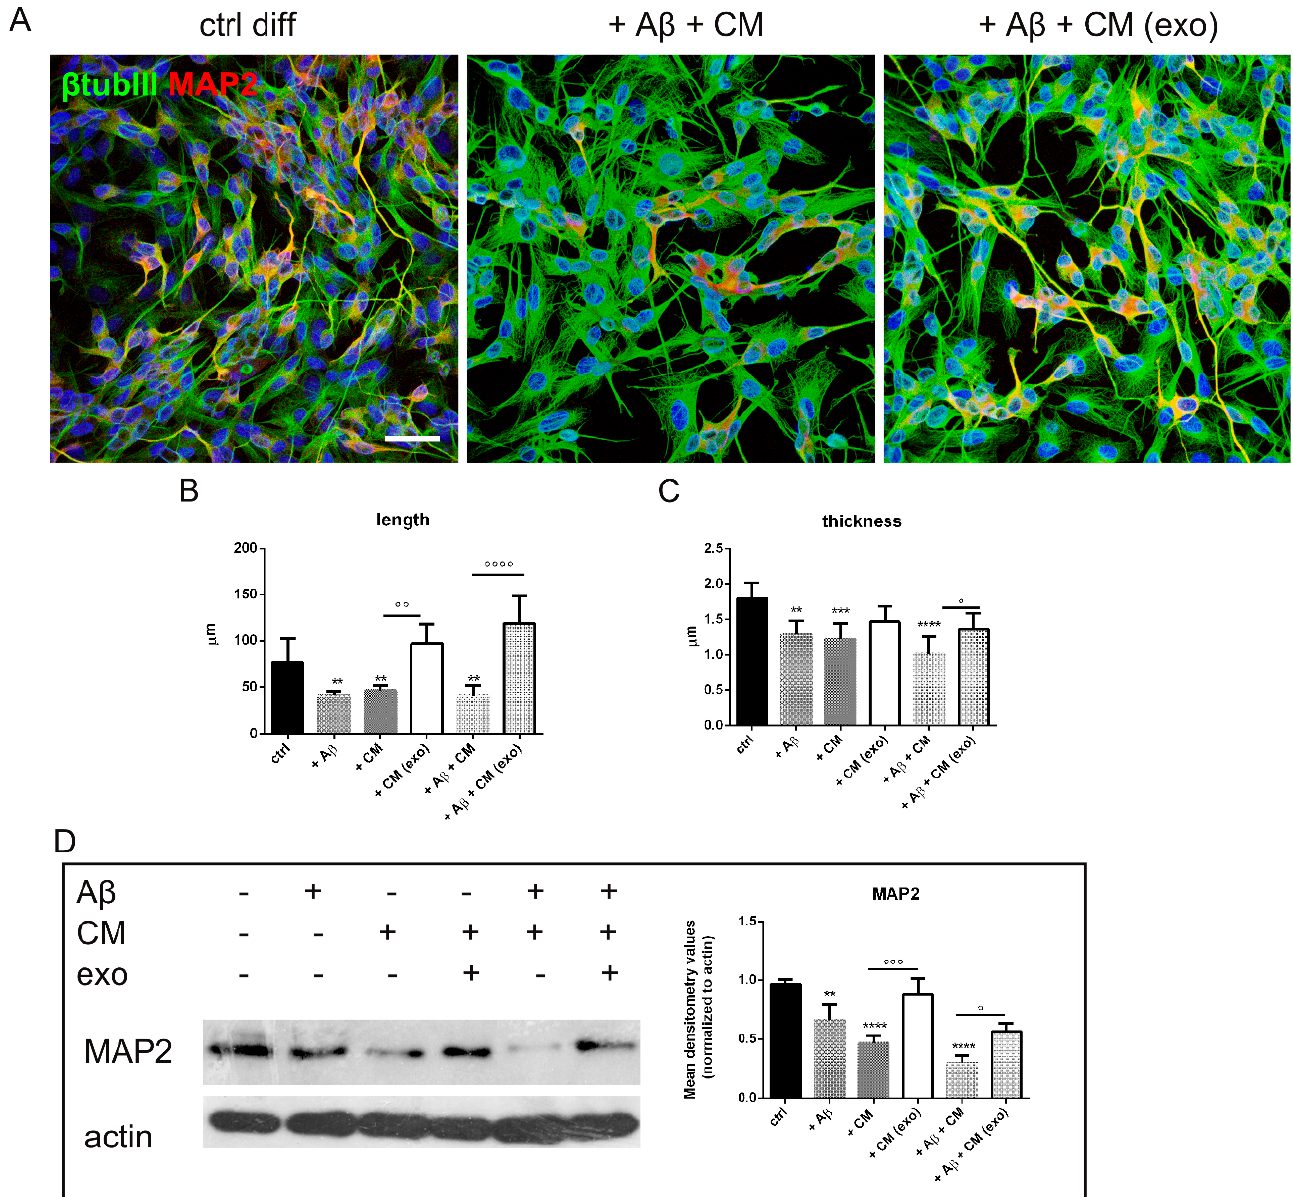
Figure 5. Indirect effect of hAFSC-exo on SH-SY5Y morphology. ( A ) Representative images with DAPI (blue), β tubulin III (green) and MAP2 (red) signals of neurons treated as previously reported. Scale bar: 20 µm. ( B , C ) Graphs showing length and thickness values measured in 100 SH-SY5Y cells per condition considering β tubulin III staining. Length: A β ** p = 0.008; CM ** p = 0.008; A β + CM ** p = 0.009; ◦◦ p = 0.002; ◦◦◦◦ p -value < 0.0001. Thickness: ◦ p = 0.035; ** p = 0.0042; ◦◦ p -value = 0.0029; *** p = 0.0006; **** p -value < 0.0001. ( D ) Western blot analysis of total lysate of SH-SY5Y cells treated or not with BV-2 CM and/or A β in presence or absence of exo, then revealed with anti-MAP2 and anti-actin as a loading control. The graph represents the mean ± SD of densitometric analysis of 3 experiments normalized to actin values. ◦ p = 0.025; ** p = 0.005; ◦◦◦ p = 0.0003; **** p -value < 0.0001.